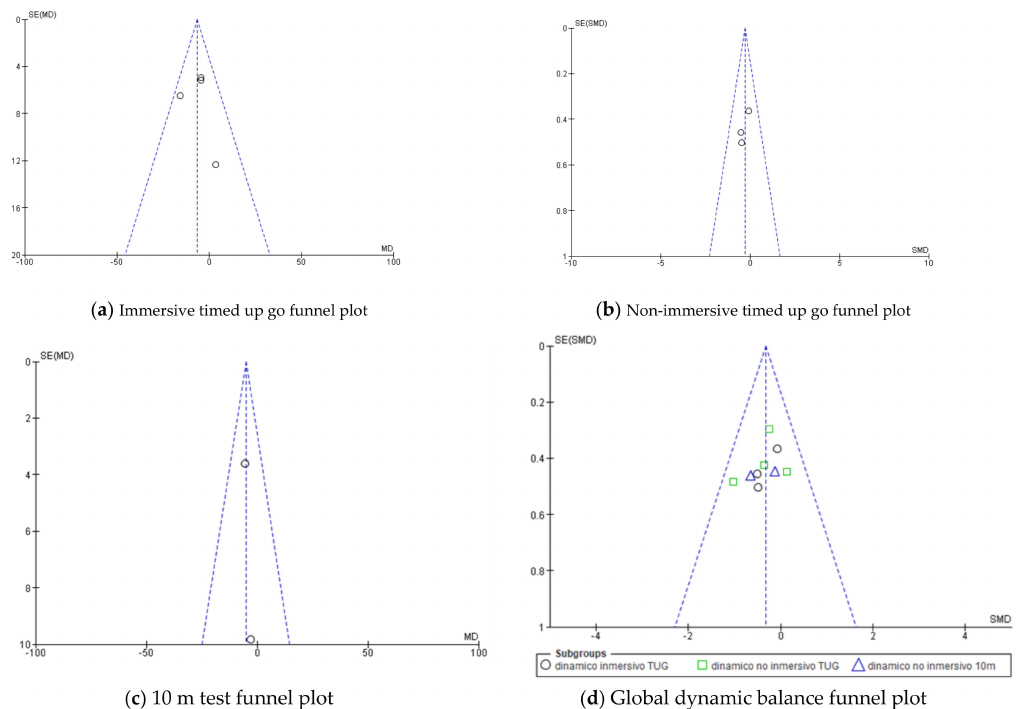
Figure 12. Funnel plots for dynamic balance. ( a ) Immersive timed up and go funnel plot, ( b ) non-immersive timed up and go funnel plot, ( c ) 10 m test funnel plot, and ( d ) global balance funnel plot.